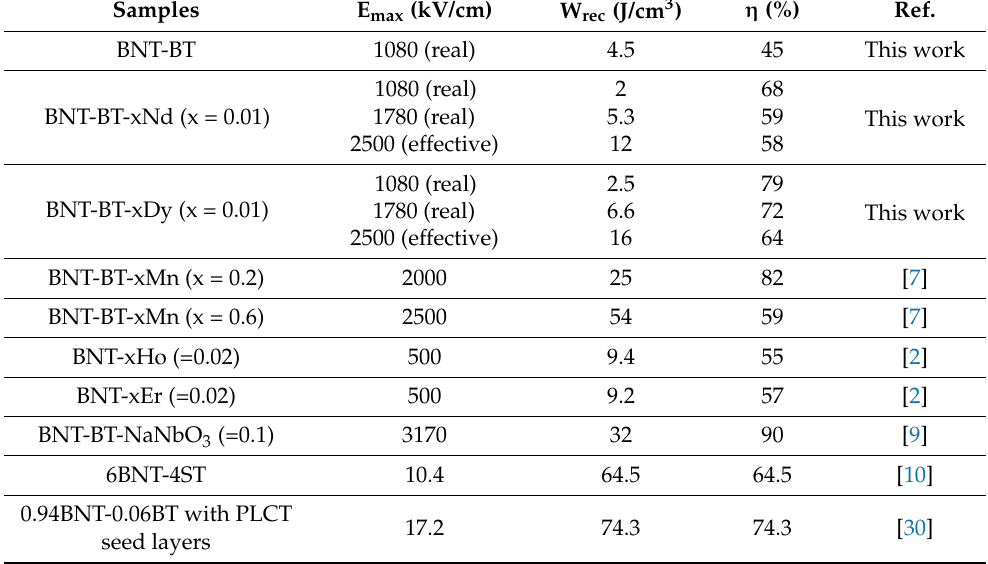
Table 1. Comparison of the energy storage parameters of the investigated thin films with some reported bibliographic data on BNT-based thin films.